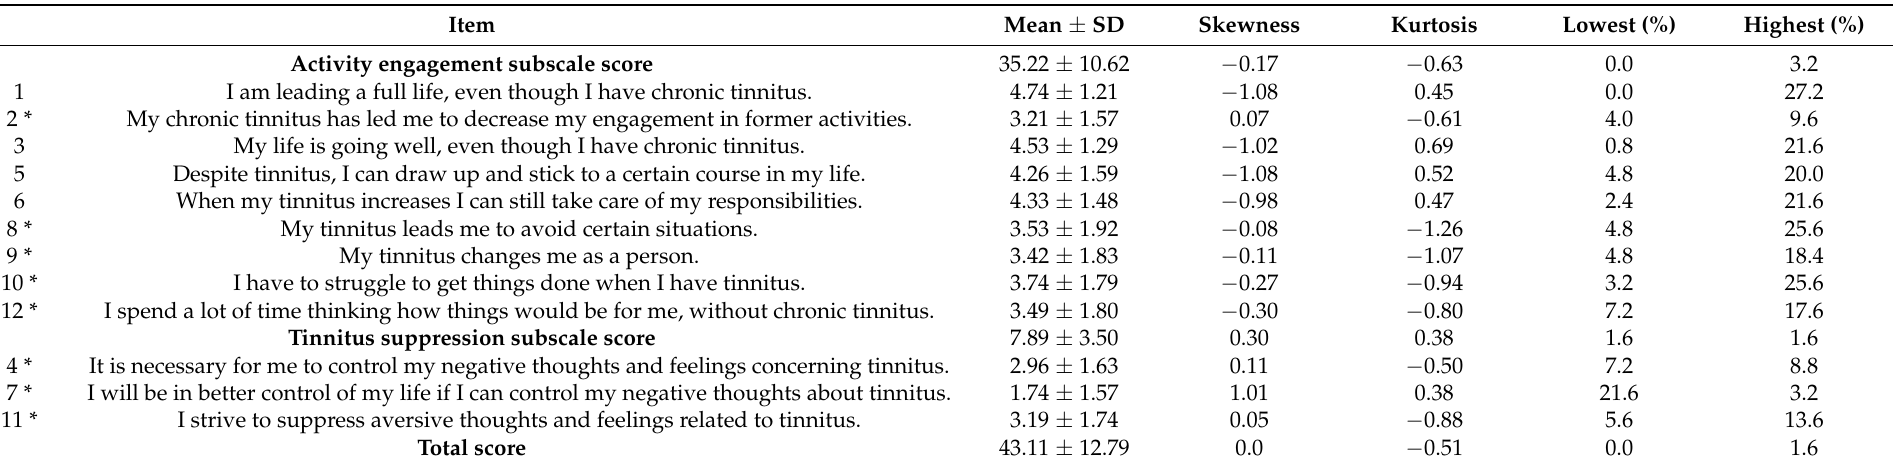
Table 1. Overall distribution profile of the Tinnitus Acceptance Questionnaire ( n =